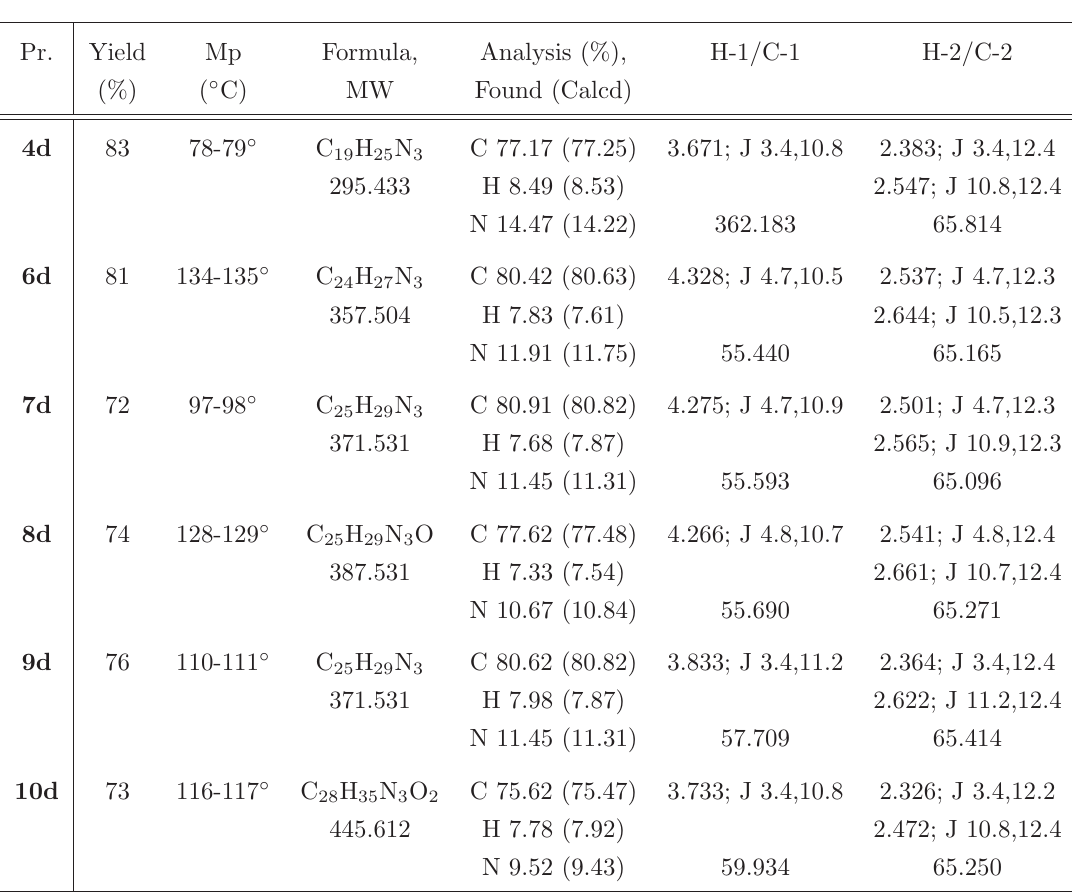
Table 2 (continue) Analytical and NMR data (CDCl 3 , δ referenced to TMS as an internal standard, J in Hz) of the skeleton nuclei of diamines 3 – 10